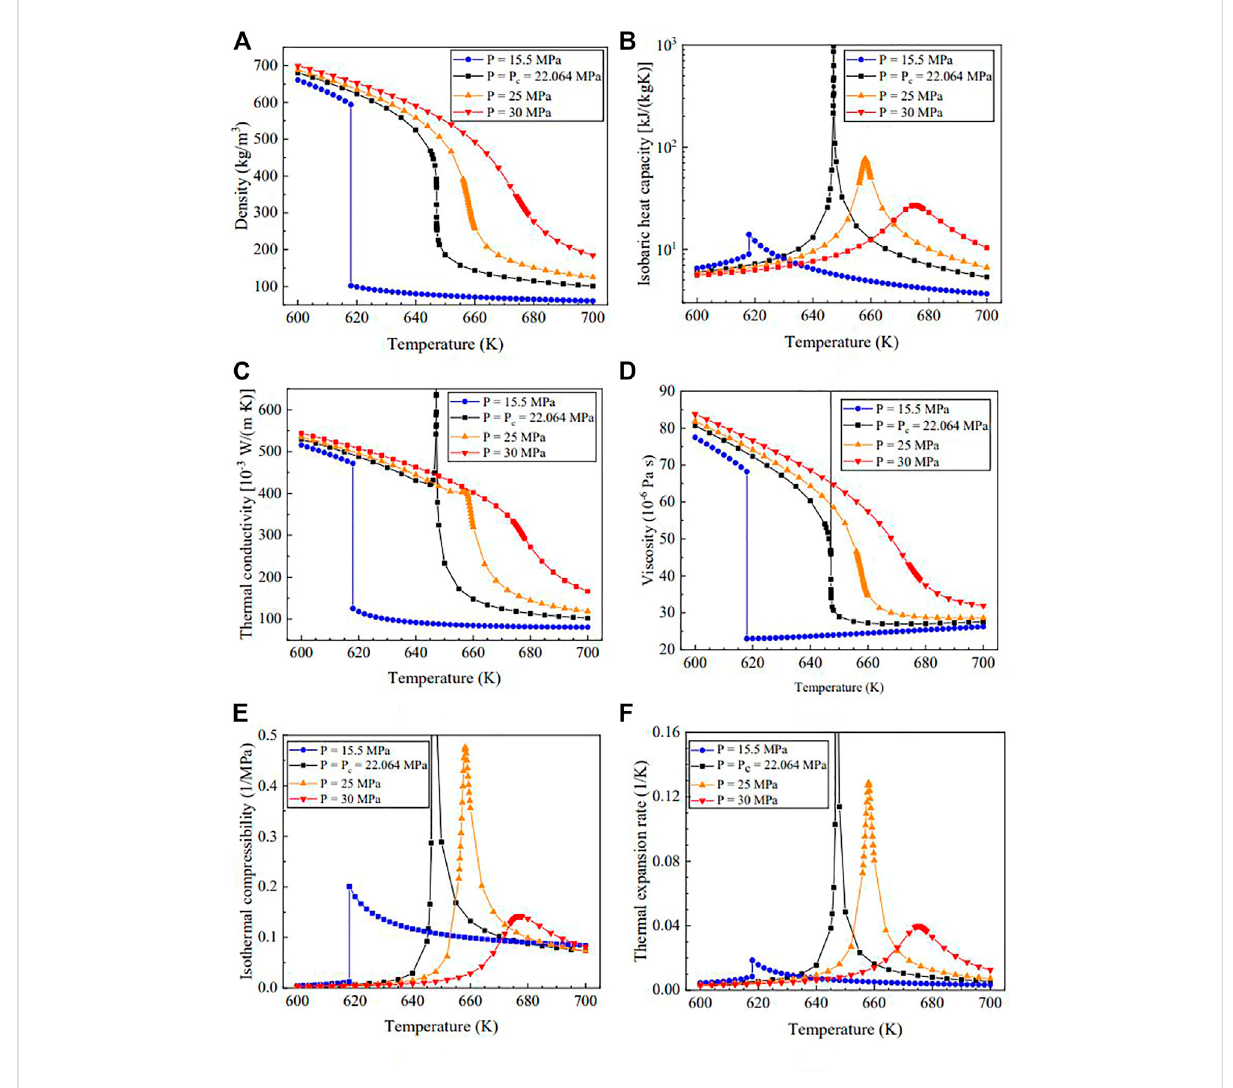
FIGURE 1 Different properties of water at different